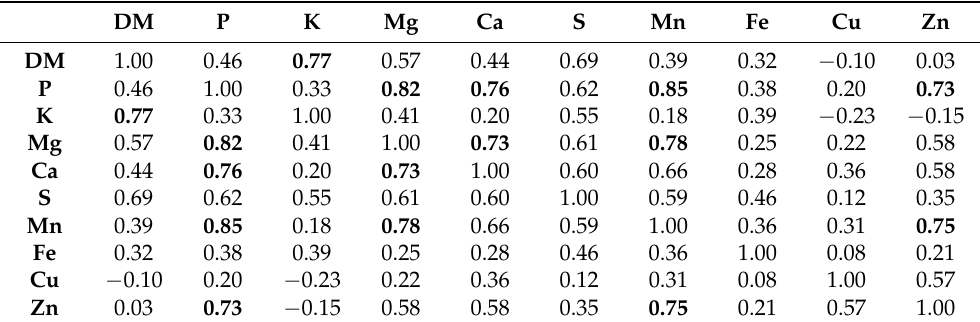
Table 3. Pearson coefficients (r) for dry matter content (DM) and element concentrations in 62 liquid manure and biogas digestate samples, determined by the standard lab procedure. Correlation coefficients over 0.70 are highlighted in bold